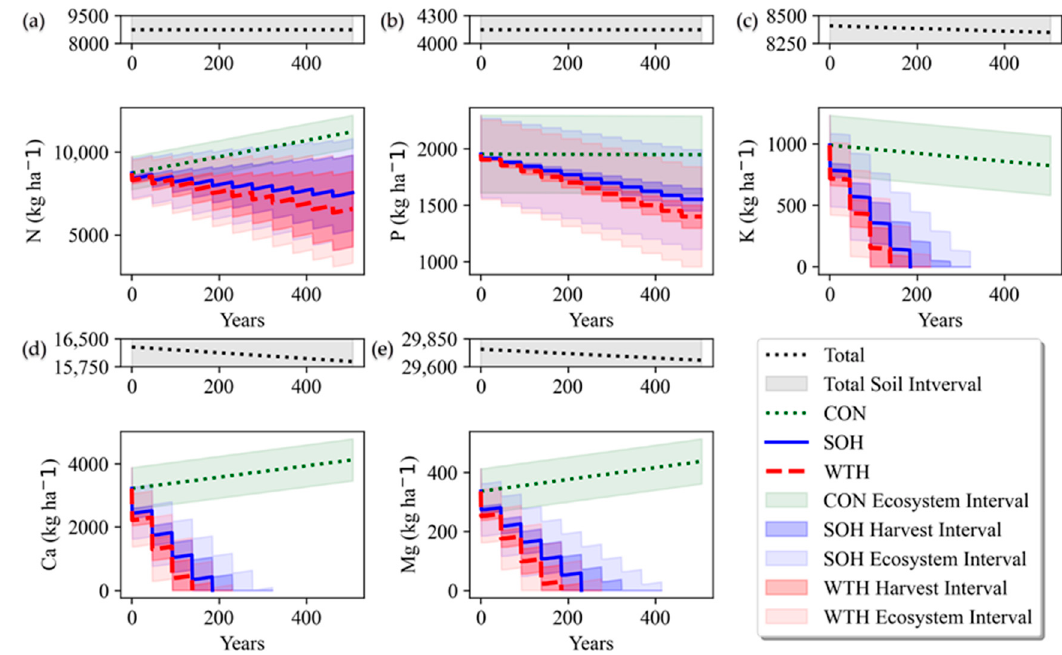
Figure 3. Simulated soil nutrients by scenario for the sampled NRCS pedons with texture-adjusted weathering rates. The N and P showed lower harvest impacts ( a ) N are totals (exchangeable unavailable) and ( b ) P total is unchanged (weathering unavailable). The depletion of K and Ca ( c , d ) is reached by 5 SOHs and 4 WTHs, and the Mg ( e ) is depleted in 6 SOHs and 5 WTHs. The control (CON) shows ( a , d , e ) accumulation in N, Ca, and Mg ( b , c ) gradual losses in P and K. Confidence intervals show large variability ( α = 0.05).